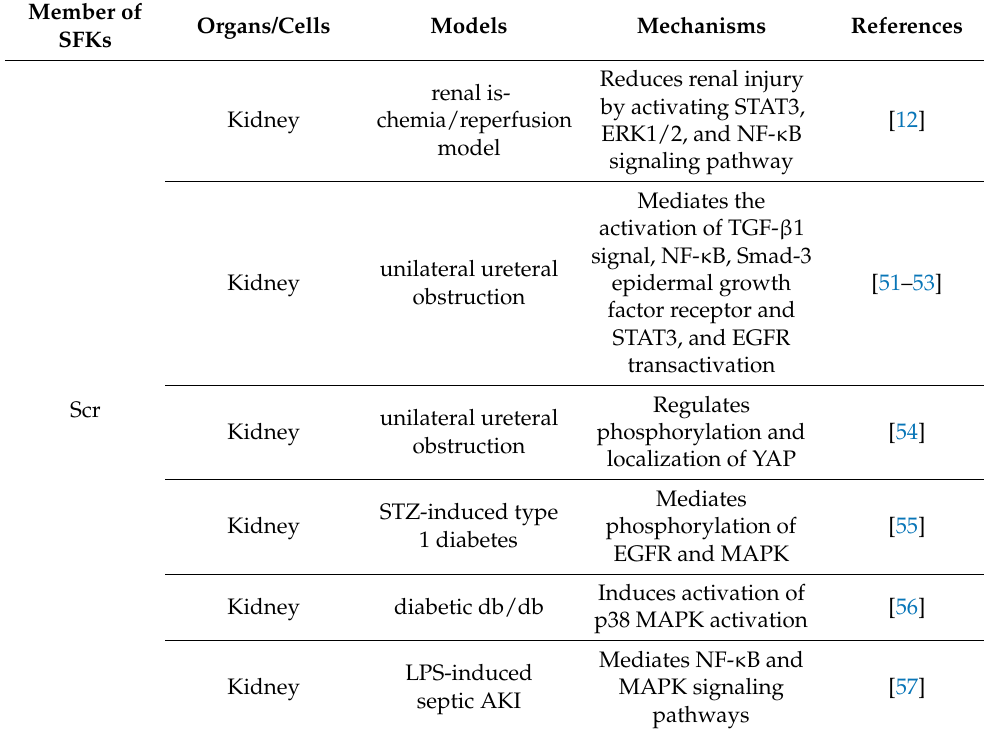
Table 1. The pathological function of SFKs in the kidney.